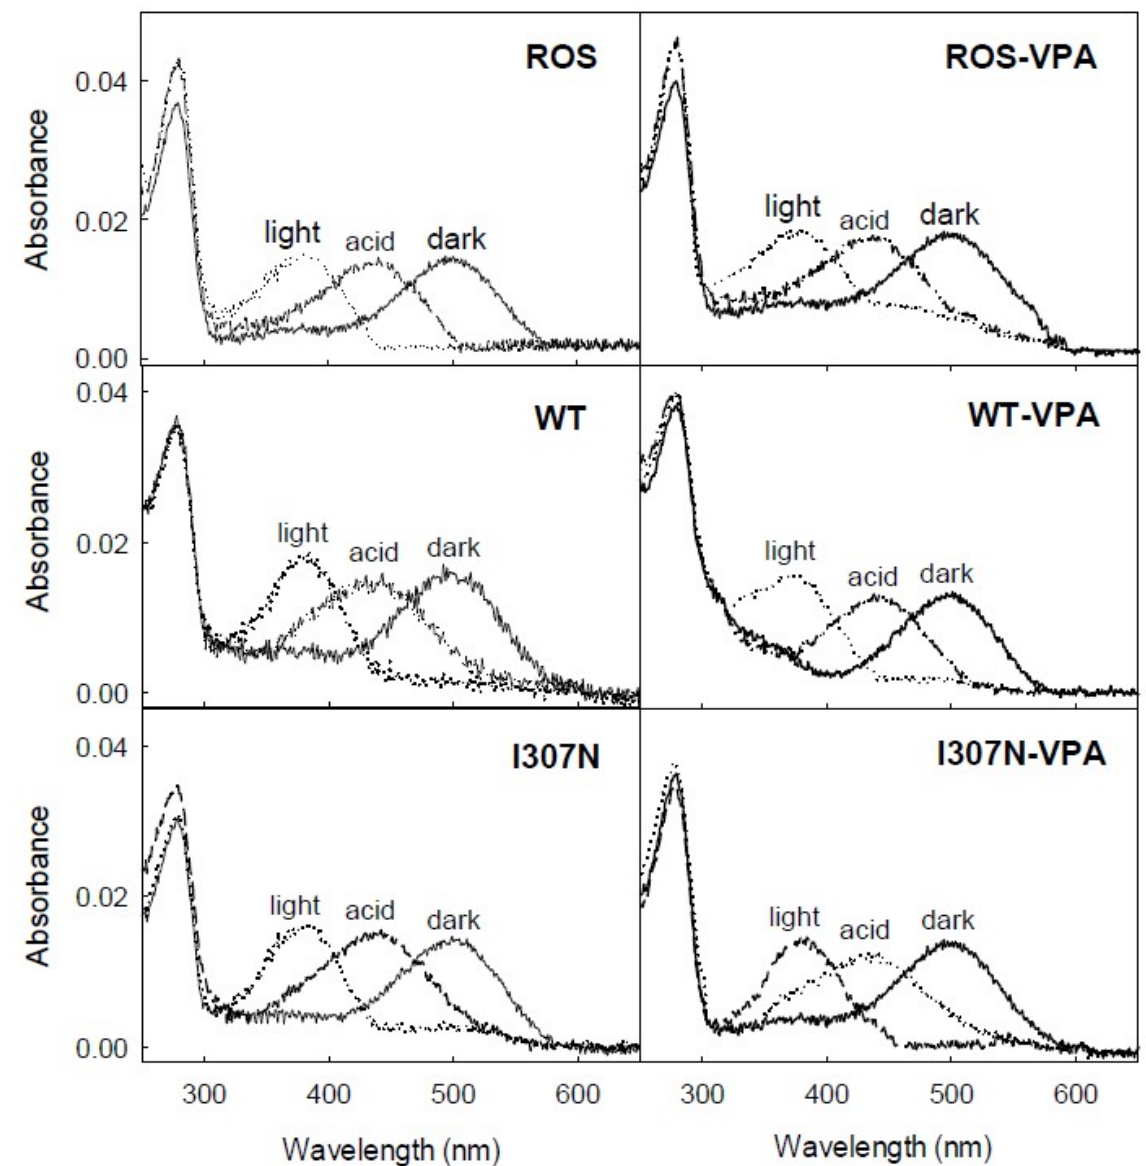
Figure 2. UV-vis photobleaching and acidification of the immunopurified ROS, WT, and RP mutant. Dark state (solid line), photobleached (dashed line), and acidified (dotted line). Samples in buffer B (137 mM NaCl, 2.7 mM KCl, 1.5 mM KH 2 PO 4 , and 8 Mm Na 2 HPO 4 , pH 7.4, 0.05% DM). Spectra were recorded at 20 °C.